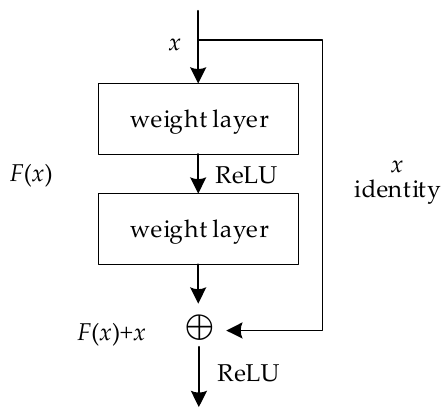
Figure 2. The identify block of ResNet.